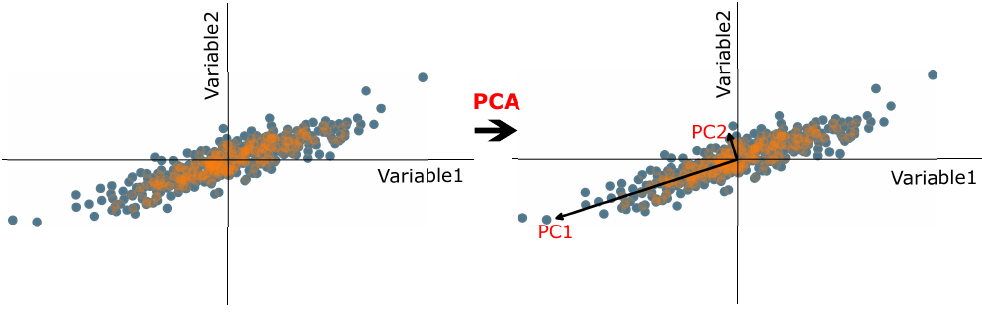
Figure 2. PCA in the 2-dimensional